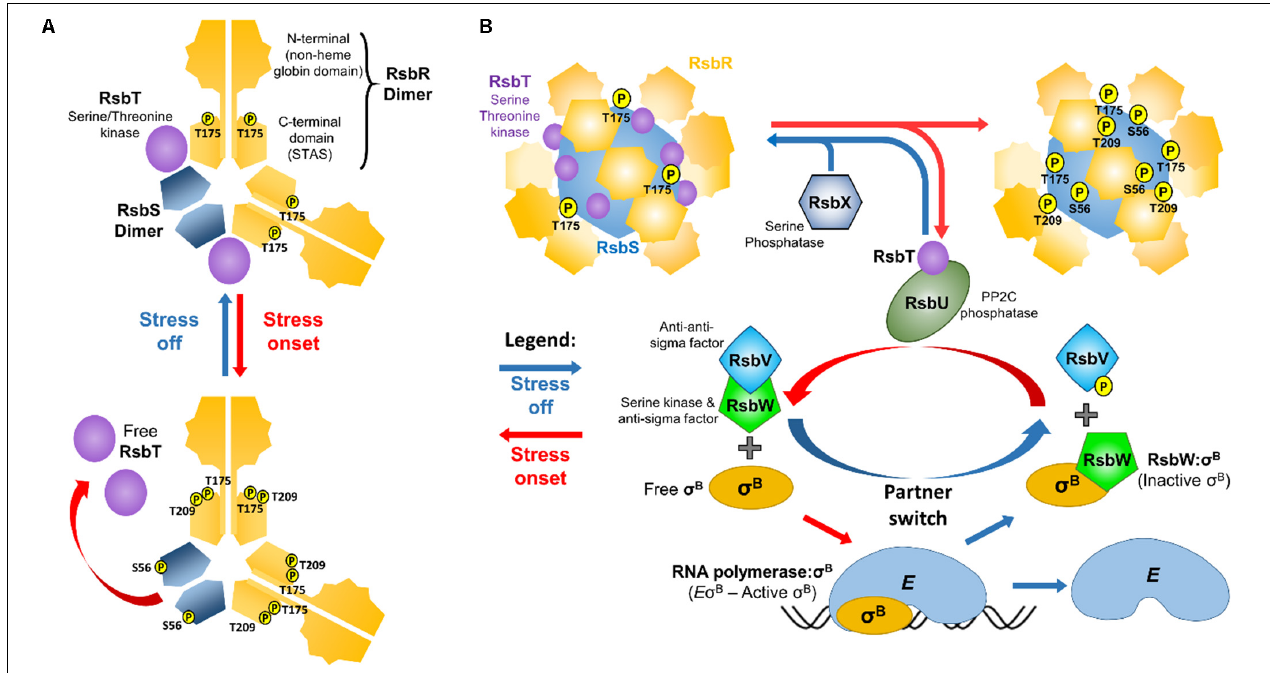
FIGURE 1 | Schematic representation of the o B regulatory pathway in L. monocytogenes. (A) The repeating hexagonal subunits of the stressosome that are composed of two dimers of RsbR, one dimer of RsbS, and two monomers of RsbT (Williams et al., 2019). It is hypothesized that the N-terminal turrets formed by the RsbR dimers detect stress signals, triggering conformational changes that propagate into the STAS domains, initiating the kinase activity of RsbT. This results in the phosphorylation of RsbR Thr209 and Thr175 and RsbS Ser56, which in turn leads to the release of RsbT from the stressosome. (B) Free RsbT interacts with and activates the RsbU phosphatase, which acts on phosphorylated RsbV. Simultaneously, the anti-sigma factor RsbW that binds and prevents σ B from interacting with the RNA polymerase ( E ), releases σ B and preferentially interacts with non-phosphorylated RsbV. σ B can then interact with RNA polymerase forming the holoenzyme E σ B . Once stress is removed, RsbX dephosphorylates the stressosome (except for RsbR Thr175 which remains phosphorylated; Misra et al., 2011), resulting in the sequestration of RsbT back into the stressosome and inactivating the signal